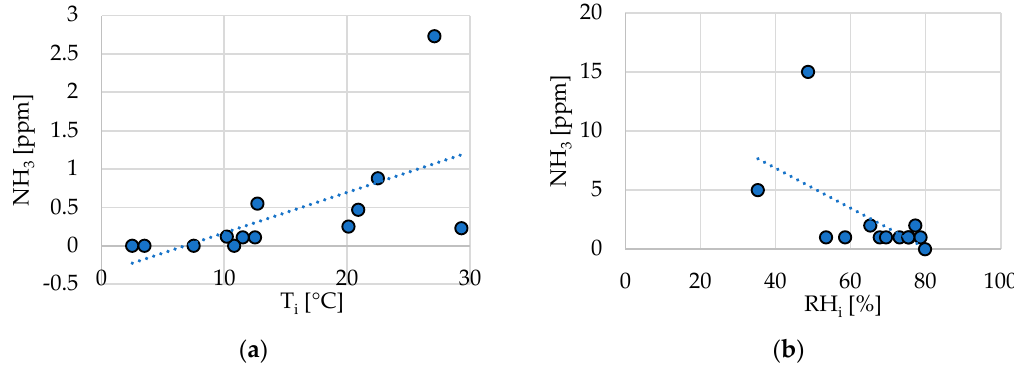
Figure 4. Correlation diagrams between NH 3 concentration in the waste storage section of biogas plant A and measured microclimatic parameters with regression lines: ( a ) R 2 = 0.37, ( b ) R 2 = 0.33. The results show positive and high correlations of T i with T o (R = 0.9888) and RH i with RH o (R = 0.7548).